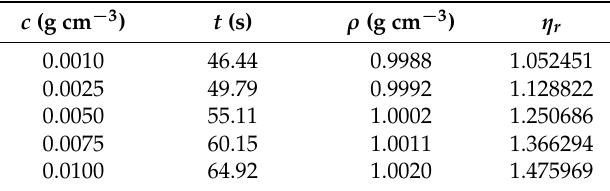
Table 1. Relative viscosity and density data as a function of BG concentration.